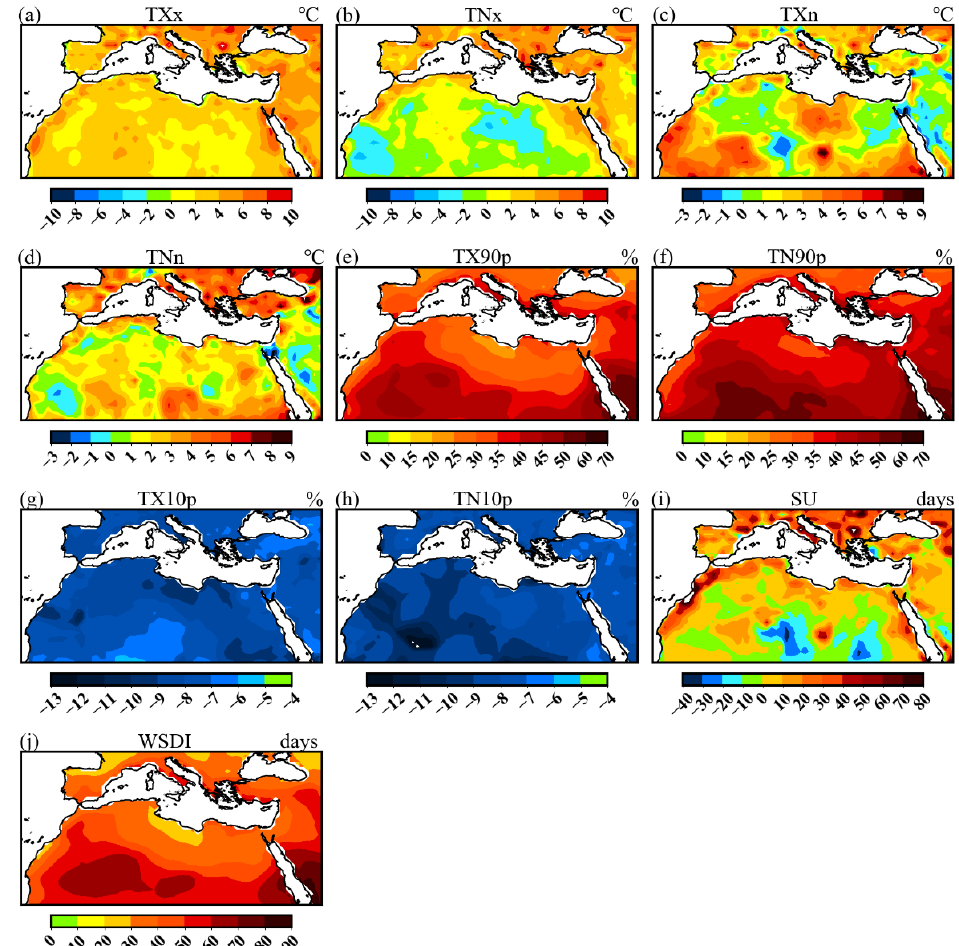
Figure 7. Same as Figure 6, but for the period 2071–2100. Considering the changes in the annual maximum value of the daily minimum tem- perature (TNx) under different scenarios and timescales, these also show distinct changes. Under the SSP2-4.5 scenario, a notable increase in TNx is projected to occur over the MED by 1 ◦ C to 3 ◦ C as compared to SAH, which will experience slight changes at − 2 ◦ C to 0 ◦ C in most parts during mid-century (Figures 6b and 10b). However, in the far-future, a persistent higher increase in the warmest nights is projected to occur over MED at 2 ◦ C to 5 ◦ C compared to SAH at 0 ◦ C to 2 ◦ C (Figures 7b and 10b). Interestingly, some regions in SAH, such as areas covering Libya and Mauritania, will experience less changes in TNx during the mid- and far-future relative to the baseline period (Figures 6b, 7b and 10b). Analysis of projected changes under a high emission scenario during the 2041–2070 period compared to 1995–2014 shows similar patterns in SSP2-4.5, but with a more intense increase in TNx at 3 ◦ C to 6 ◦ C (Figures 8b and 10b). The changes will further surge towards